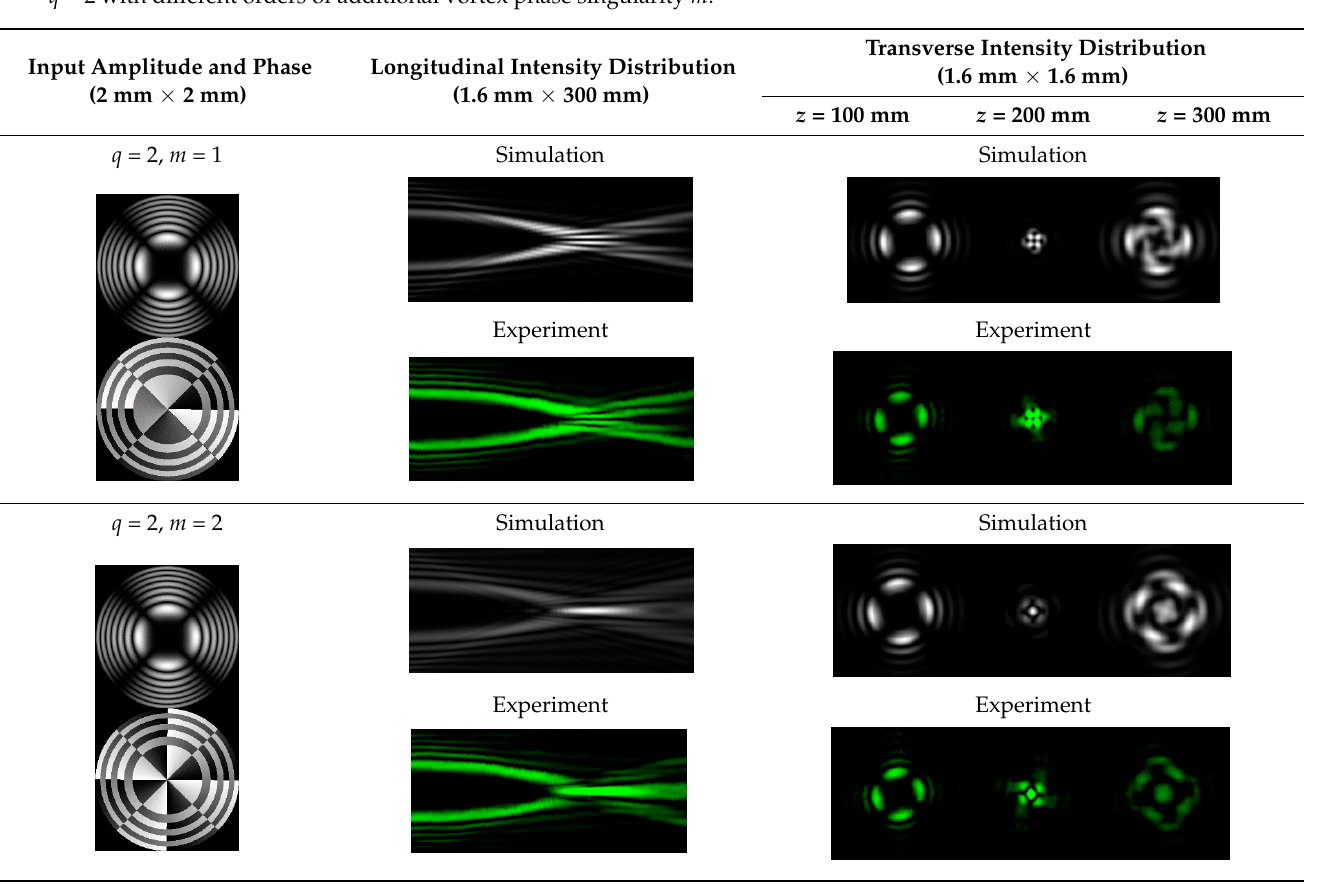
Table 2. Results of modeling and experiment for the field defined by Equation (18) with azimuthal modulation of order q = 2 with different orders of additional vortex phase singularity m .